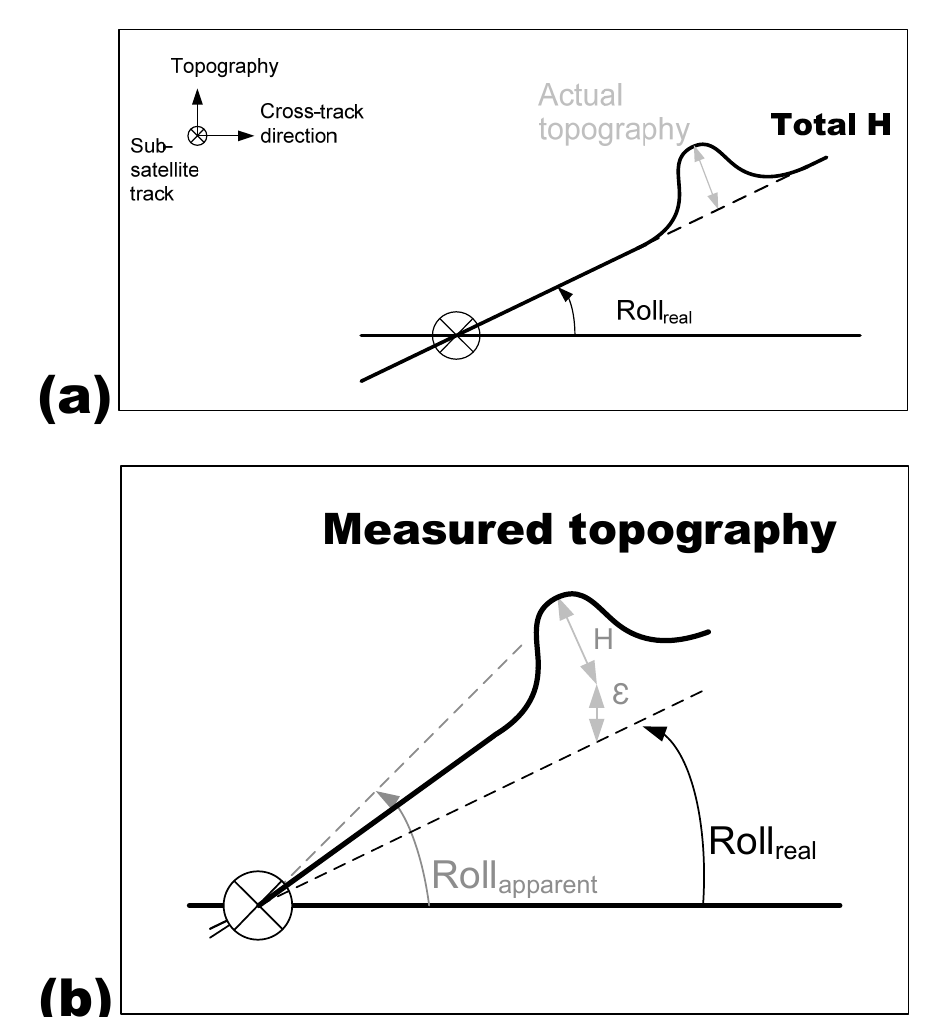
Figure 4. Empirical estimation of the roll angle from topography. ( a ) shows an ideal case where the actual topography H can be perfectly separated from the linear signature of roll, and ( b ) shows a more realistic situation where the measured topography contains cross-track gradients from H or measurement errors ε . If these gradients are misinterpreted as roll, then roll estimates would yield Roll instead of Roll apparent real